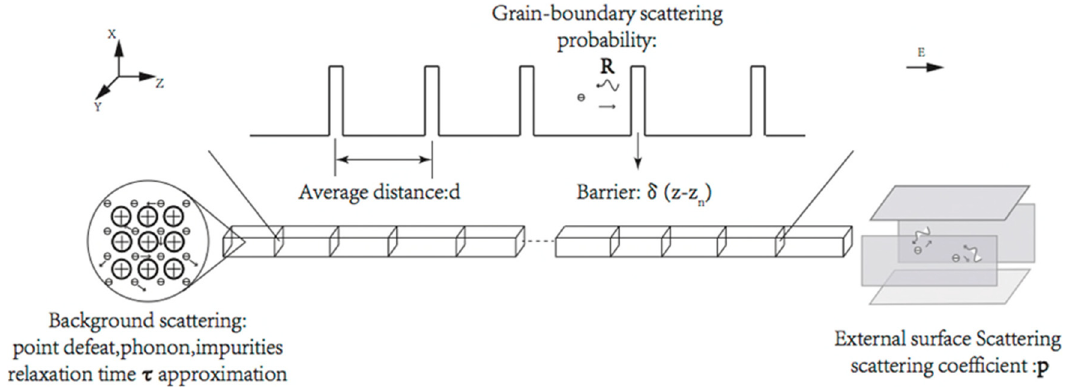
Figure 1. Illustration of the three scattering mechanisms in square cross ‐ section polycrystalline nanowires.